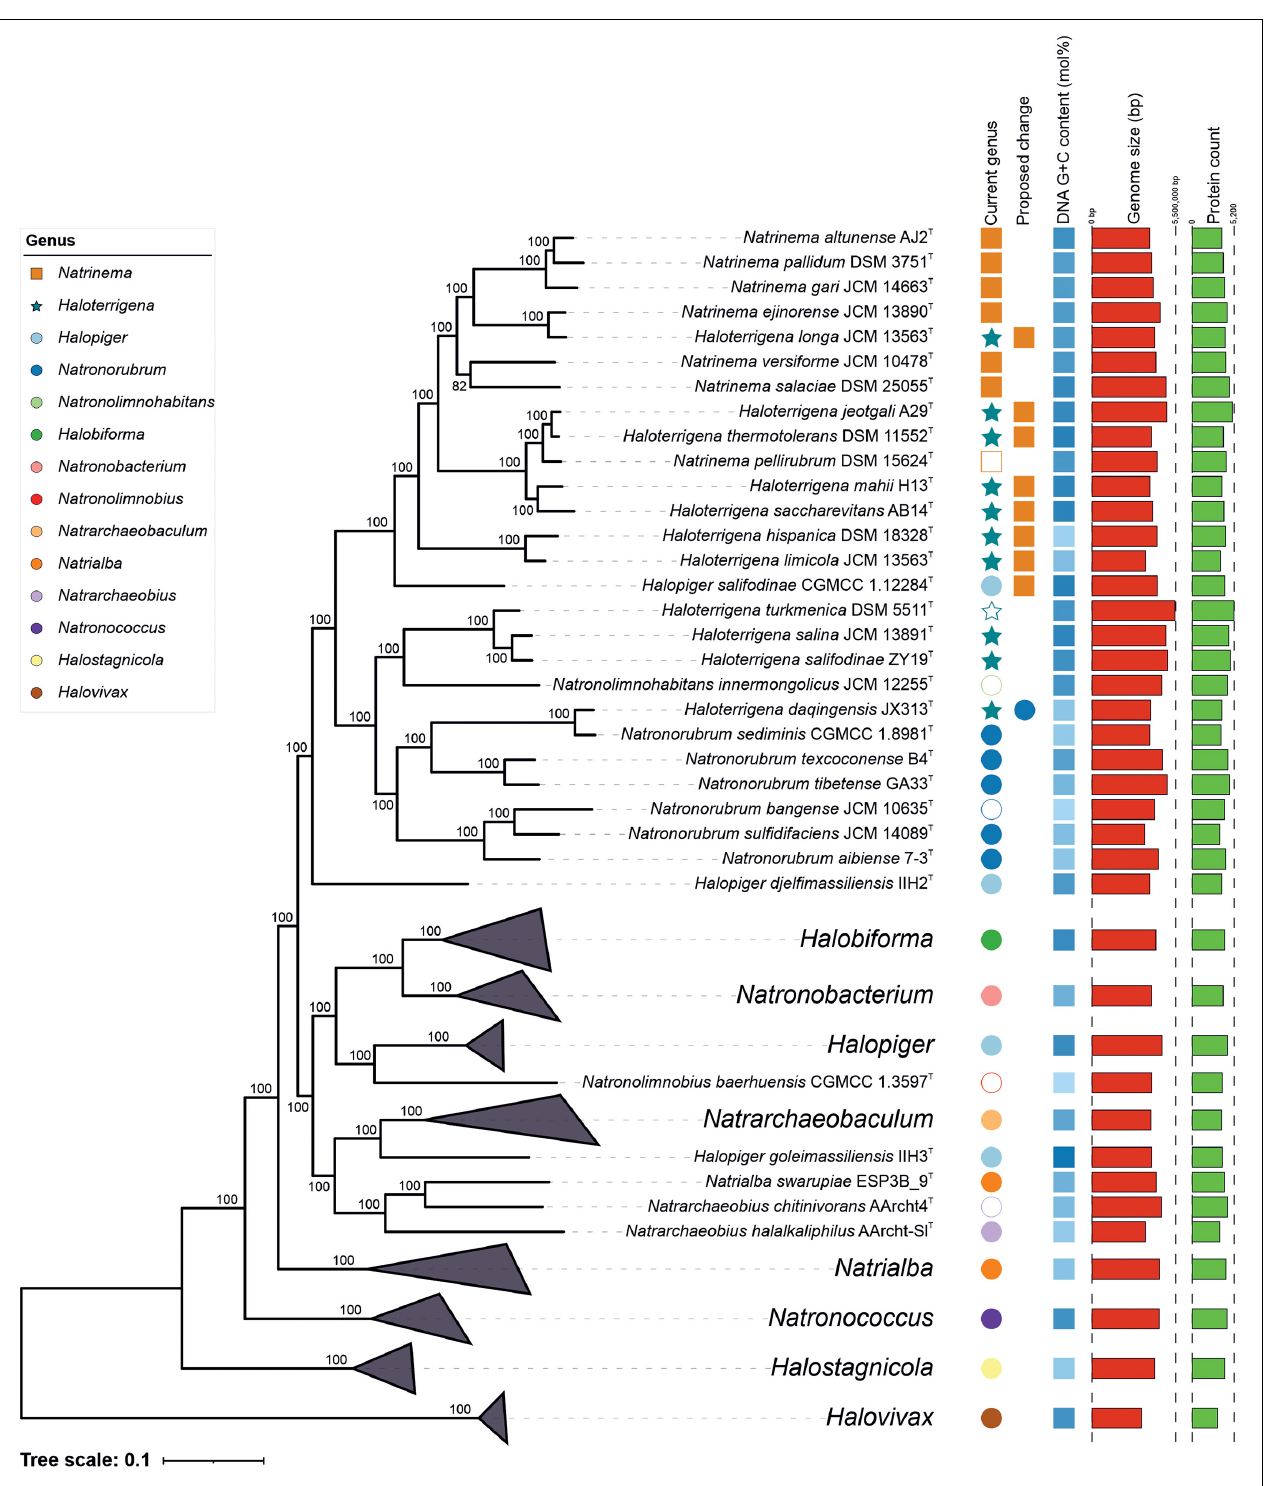
FIGURE 2 | Approximate maximum-likelihood phylogenomic tree based on the concatenation of the translated sequence of the 525 single-copy genes shared by the type strains of members of the genera Natrinema and Haloterrigena and related taxa of the family Natrialbaceae under study. Bootstrap values ≥ 70% (based on Shimodaira-Hasegawa-like local support) are shown above the branches. Bar, 0.1 changes per nucleotide position. Empty symbols indicate the type species of the corresponding genus.